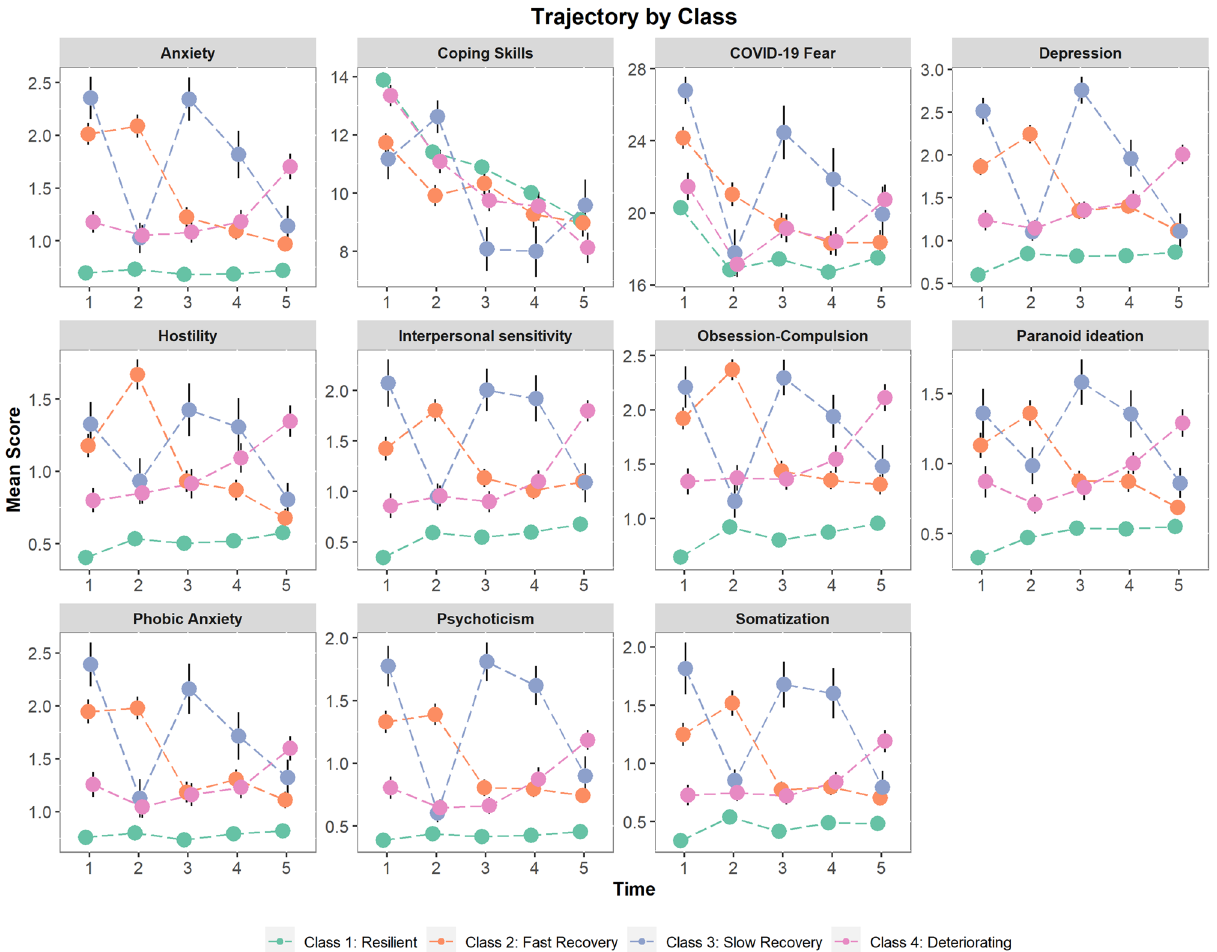
Figure 4. Estimated mean scores for each symptom dimension (BSI-53) and state-measures from the four-class solution of the Growth Mixture Model (GMM) over time. Class membership was estimated previously from Psychological Distress (GSI) scores. Error bars represent standard